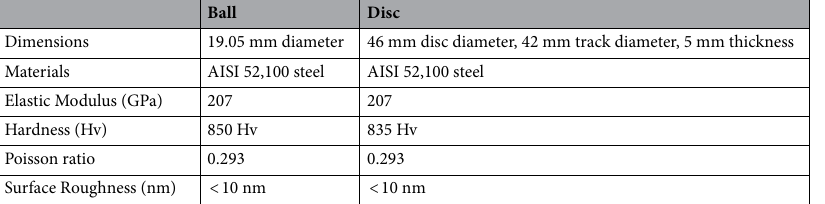
Table 1. Dimensions and materials properties of rubbing